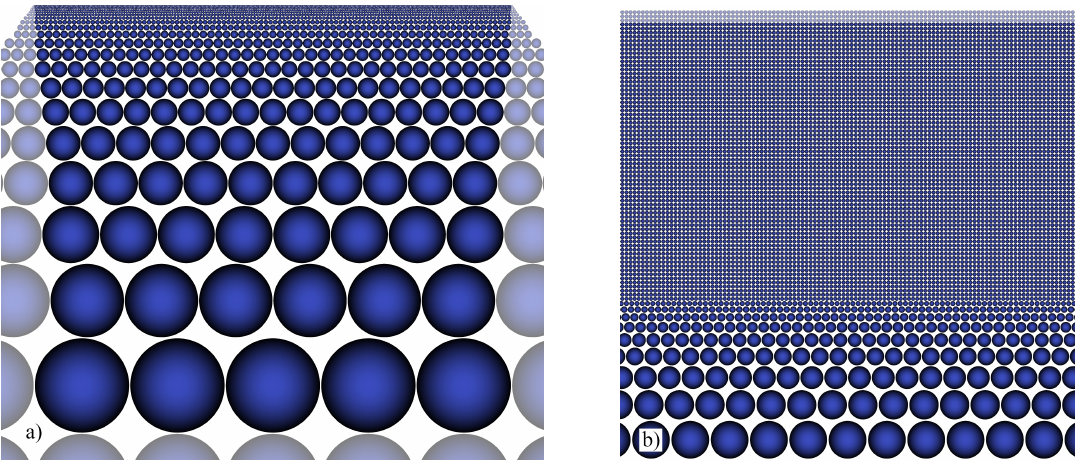
Figure 2. Discretisation of computational domain by particles, details of (dummy particles less opaque) ( a ) 5 µm × 4.5 µm, showing coarser particles starting from the bottom, and adjacent dummy particles. ( b ) 440 nm × 440 nm, fine equidistant initial distribution near the surface and coarser particles